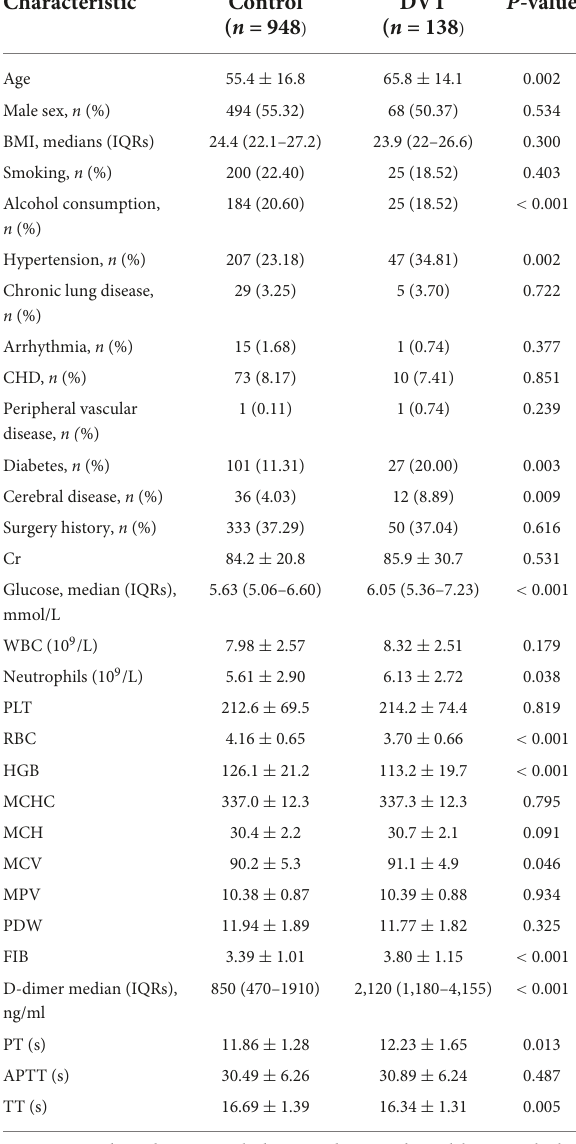
TABLE 1 Univariate analysis of factors associated with preoperative DVT ( n =